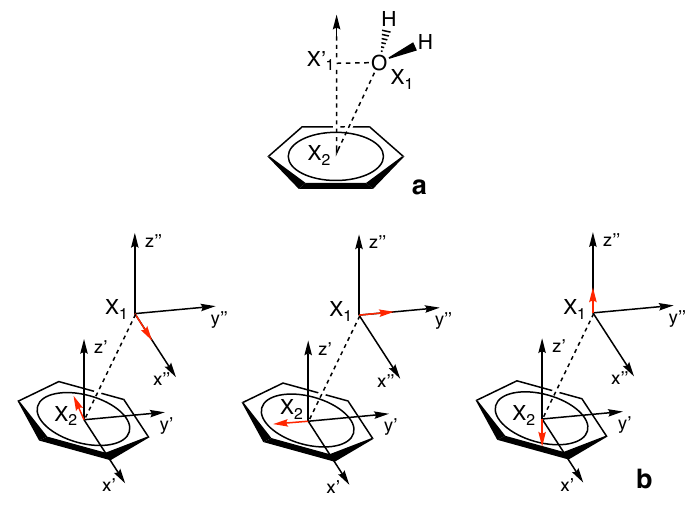
Figure 2. Schematic of how the special LVM force constant k a is defined for the π –hole interaction involving a six–membered aromatic ring as π –hole donor, where X 1 is the location of the central atom of the acceptor molecule interacting directly with the π –hole located at X 2 ; shown is complex 2